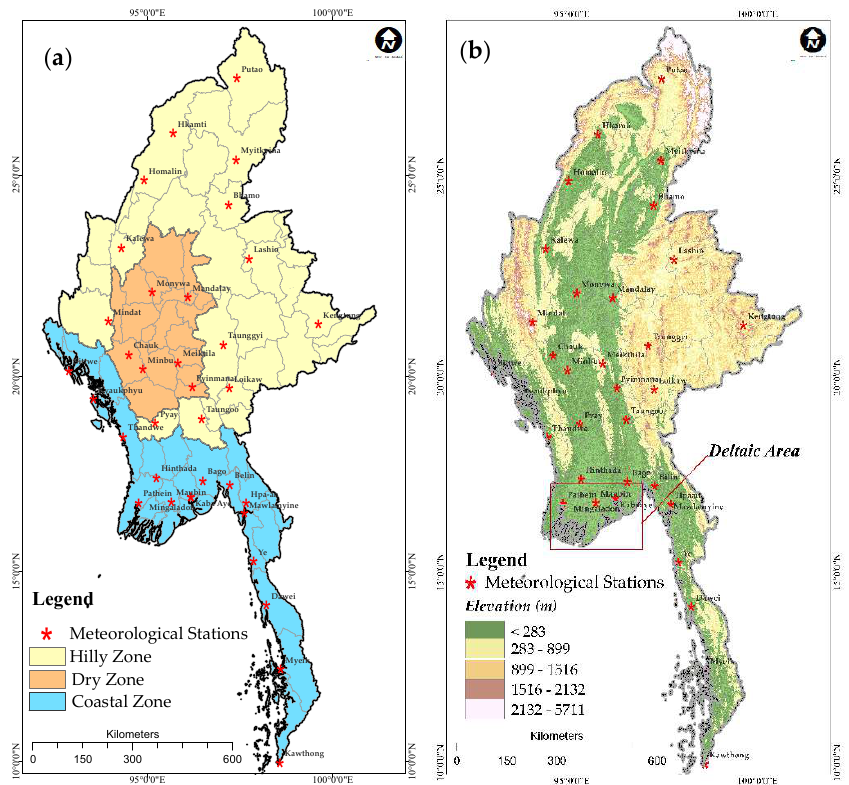
Figure 1. Map of Myanmar with locations of meteorological stations from which the data are used in the current study; ( a ) agro-ecological zone, and ( b ) elevation range (DMH, 2017). The mountain ranges over the west coast along Rakhine and southern regions receive the highest rain along the coastal area with an average annual rainfall of about 5,080 mm. The lower elevation of